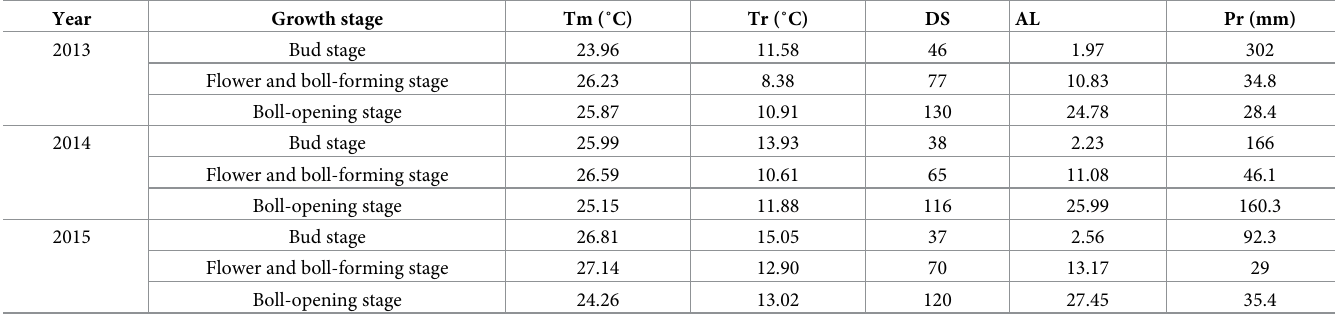
Table 4. Meteorological conditions during the cotton growing season from 2013 to